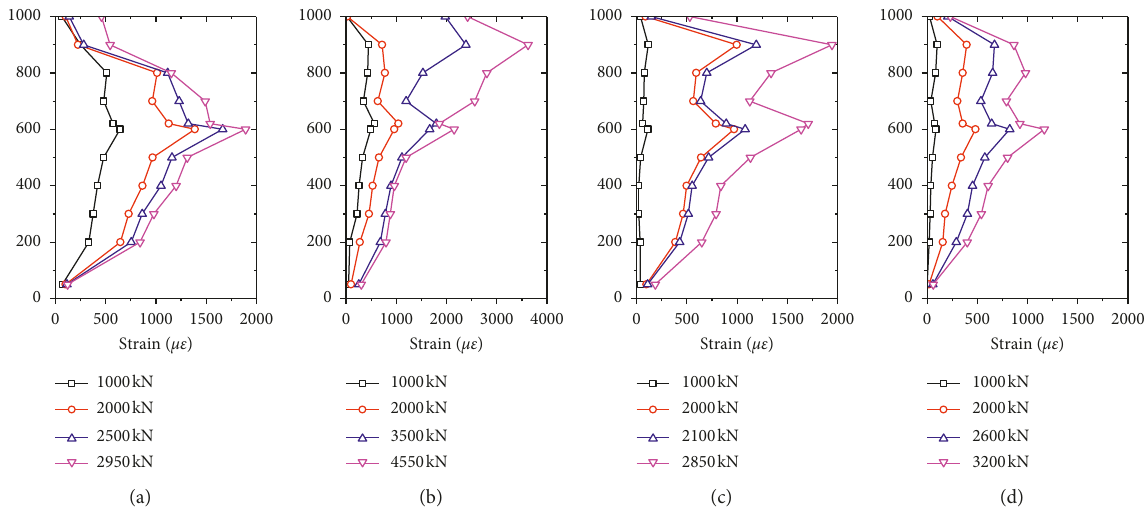
Figure 9: Strain distribution along the steel tube: (a) SJ1-1; (b) SJ1-2; (c) SJ1-3; (d) SJ1-4.